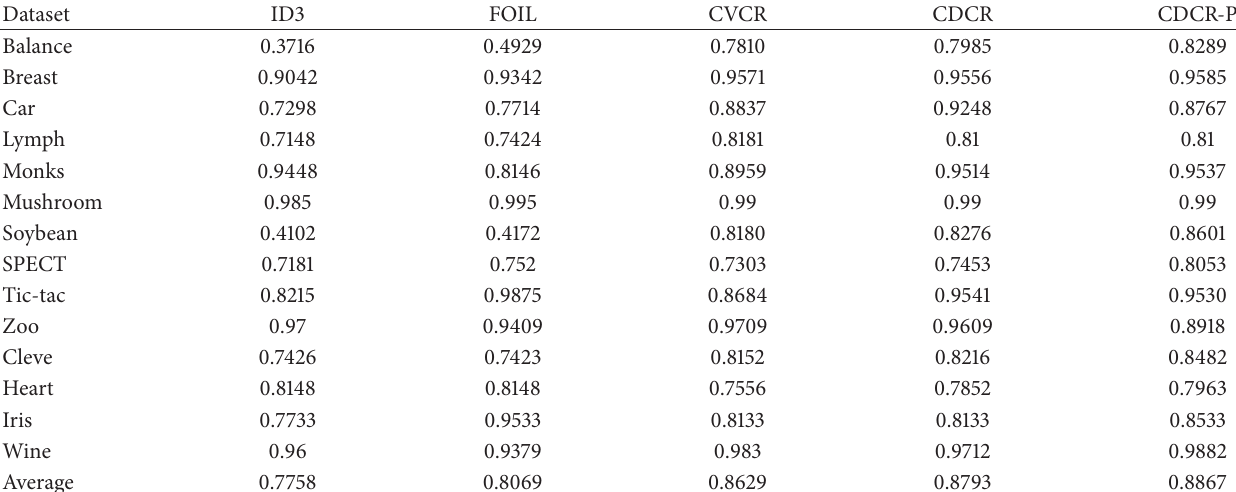
Table 2: The accuracy of ID3, FOIL, CVCR, CDCR, and CDCR-P.